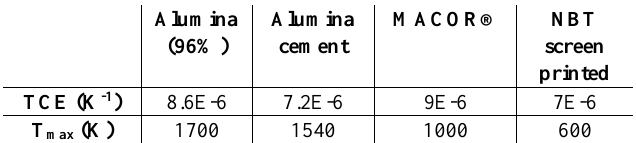
Table 1 : TCE and maximum operating temperature of the different sensor elements